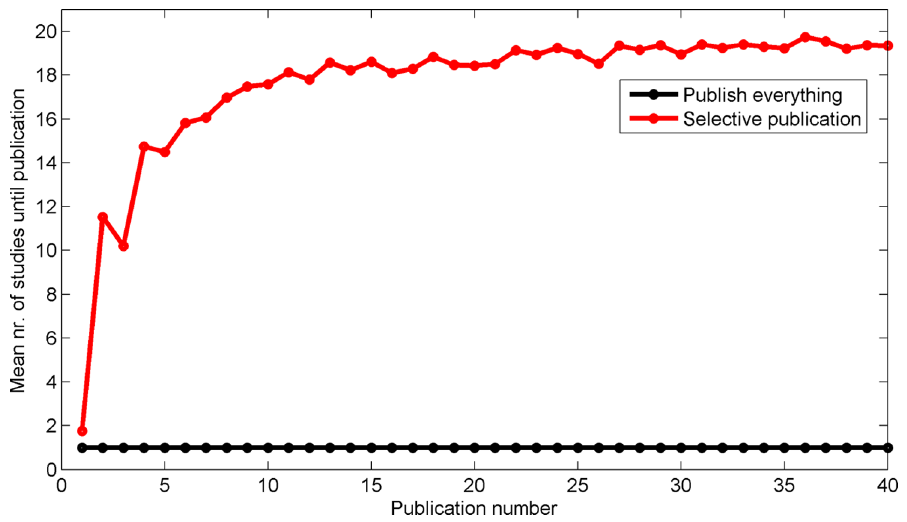
Figure 5. Mean number of studies until publication as a function of the number of publications. The means are calculated across the 5,000 repetitions of the simulation.